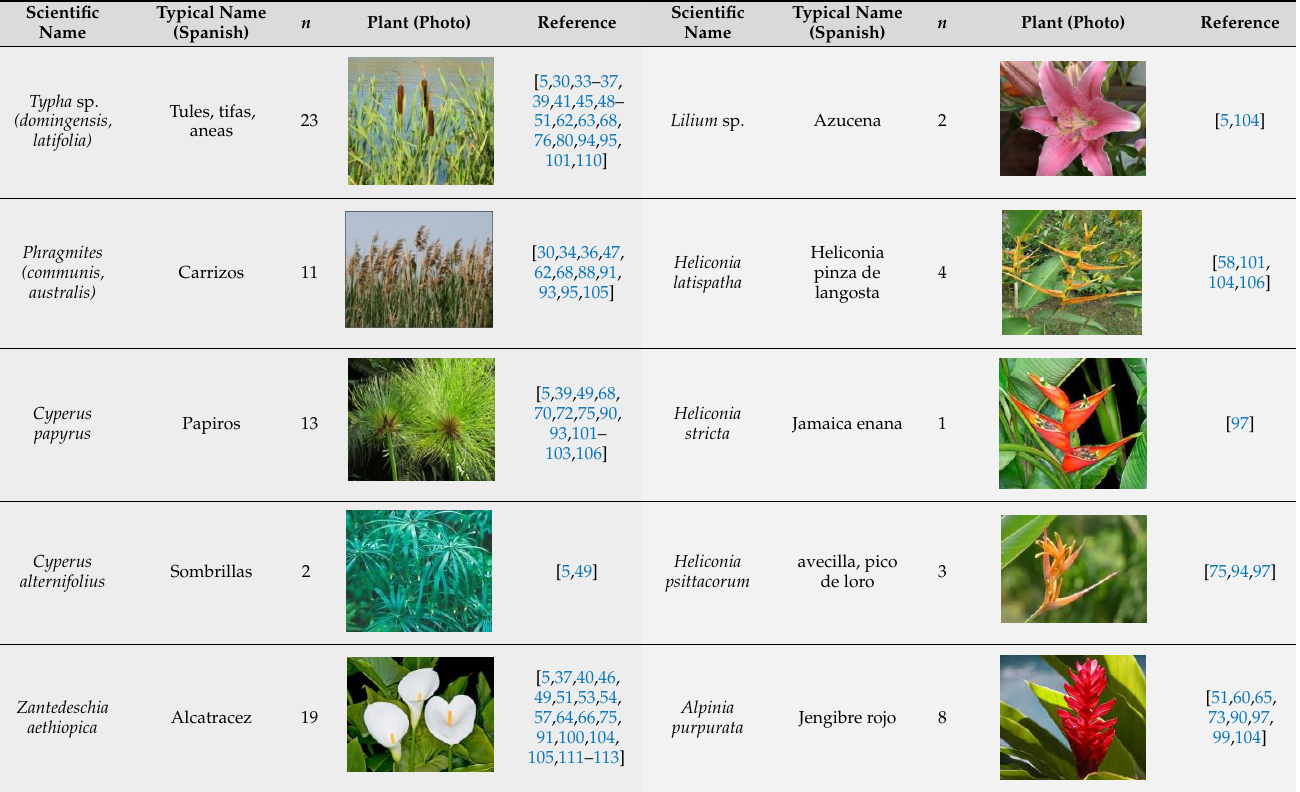
Table 2. Plant species reported in Mexican CWs.